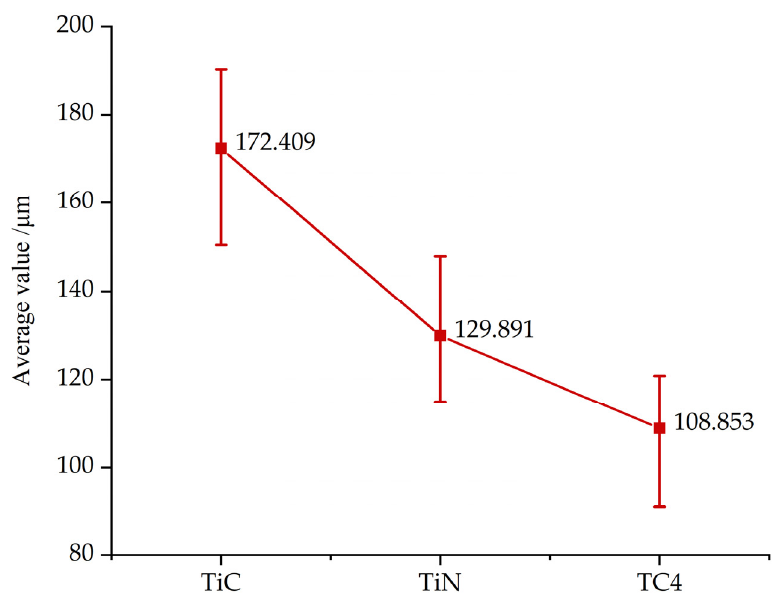
Figure 14. Deposition thickness measurement results.